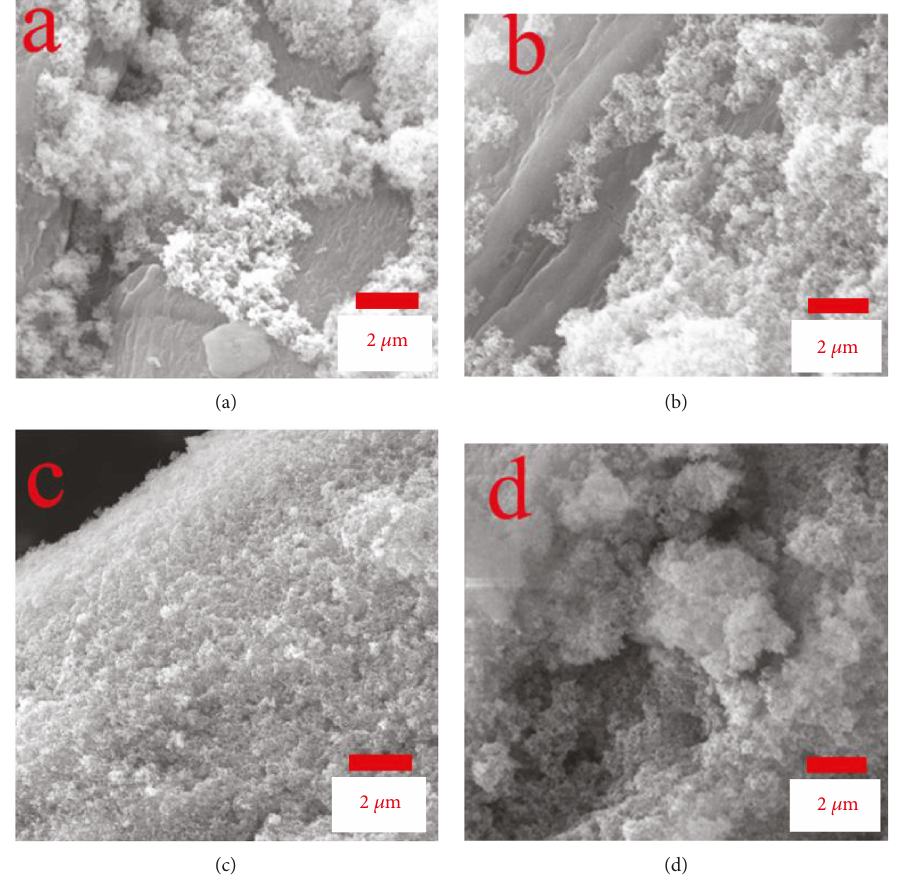
Figure 3: (a – d) SEM images of TCF05, TCF10, TCF15, and